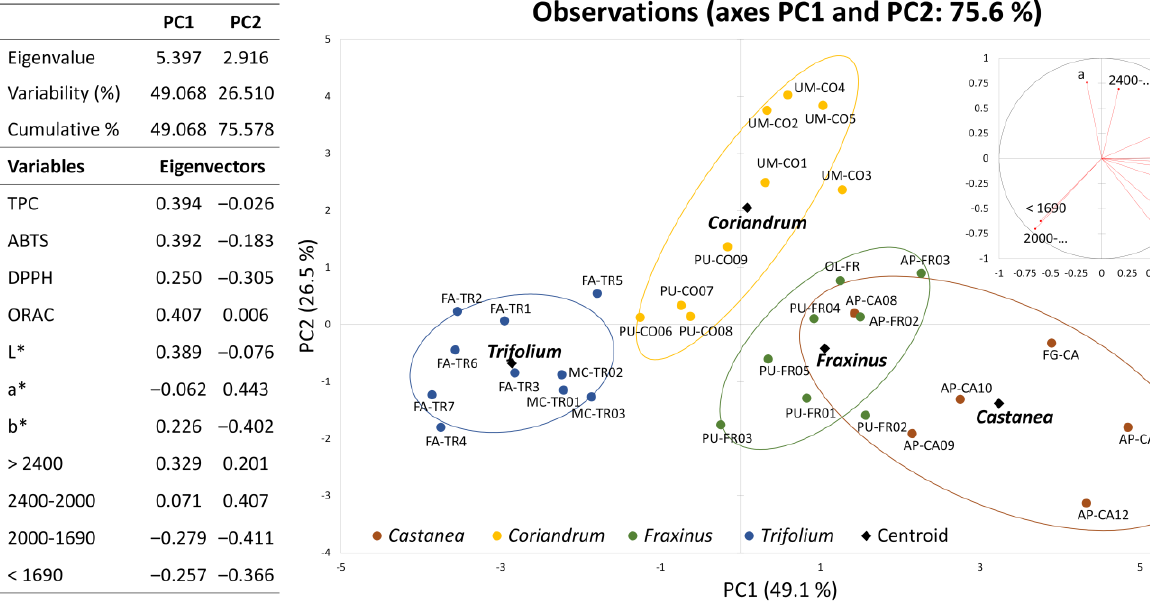
Figure 2. Principal component analysis. Loading plot and score plot of the first two components obtained from antioxidant, granulometry and colour data of pollen samples with the prevalence of species present both in unifloral [8] and actual samples. Eigenvalues, explained and cumulative variance and loadings of the variables are also reported.